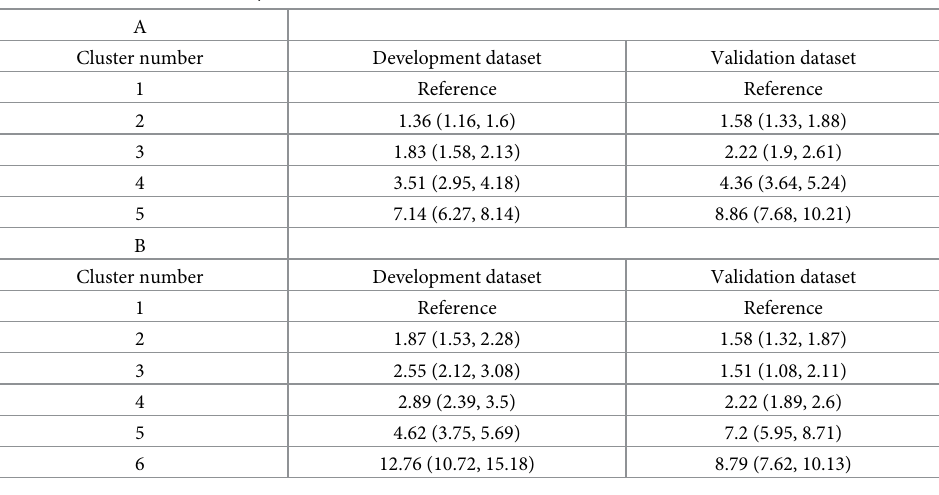
Table 2. Clusters and risk of 1-year death.